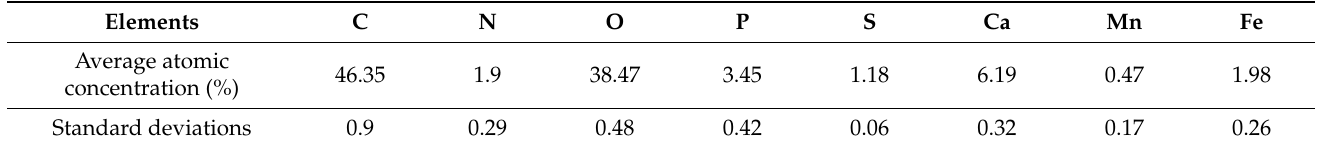
Table 5. Atomic concentrations of various elements (obtained via XPS analysis) of the fouled mem-